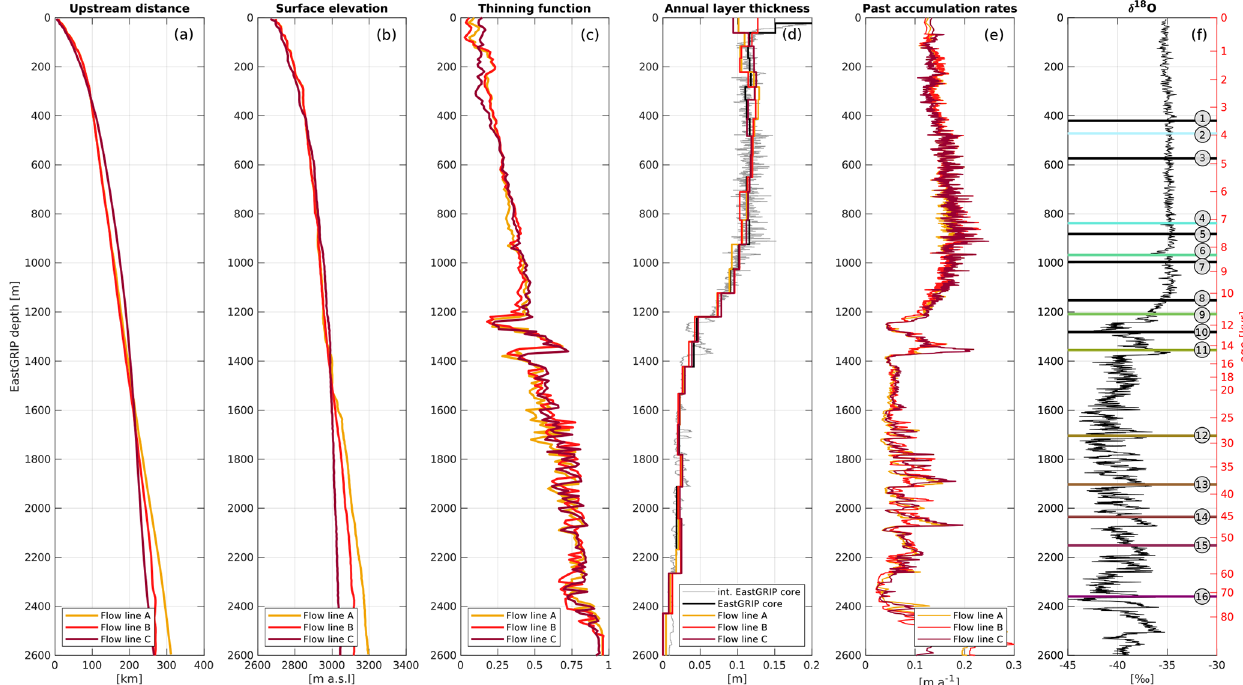
Figure 7. Modelled upstream distance (a) and surface elevation (b) of the source location for ice in the EastGRIP ice core. The thinning function (c) was calculated from the modelled accumulation rates and annual layer thicknesses (d) and was combined with the interpolated annual layer thicknesses observed in the ice core (d) to calculate past accumulation rates in high resolution (e) . The δ 18 O curve from NorthGRIP (f) was scaled to the EastGRIP depths to put the results into a climatic context. The depths of the traced isochrones from Table 3 are displayed with the same colour index as in Figs. 4 and 5 and labelled with the corresponding layer